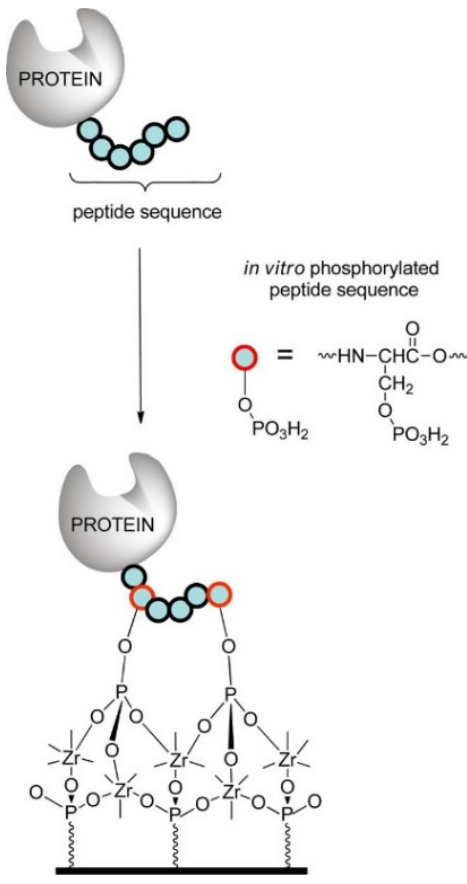
Figure 4. Covalent attachment of proteins to zirconium phosphonate surfaces via phosphopeptide anchors. Reprinted with permission from [49]. Copyright (2014) American Chemical Society.